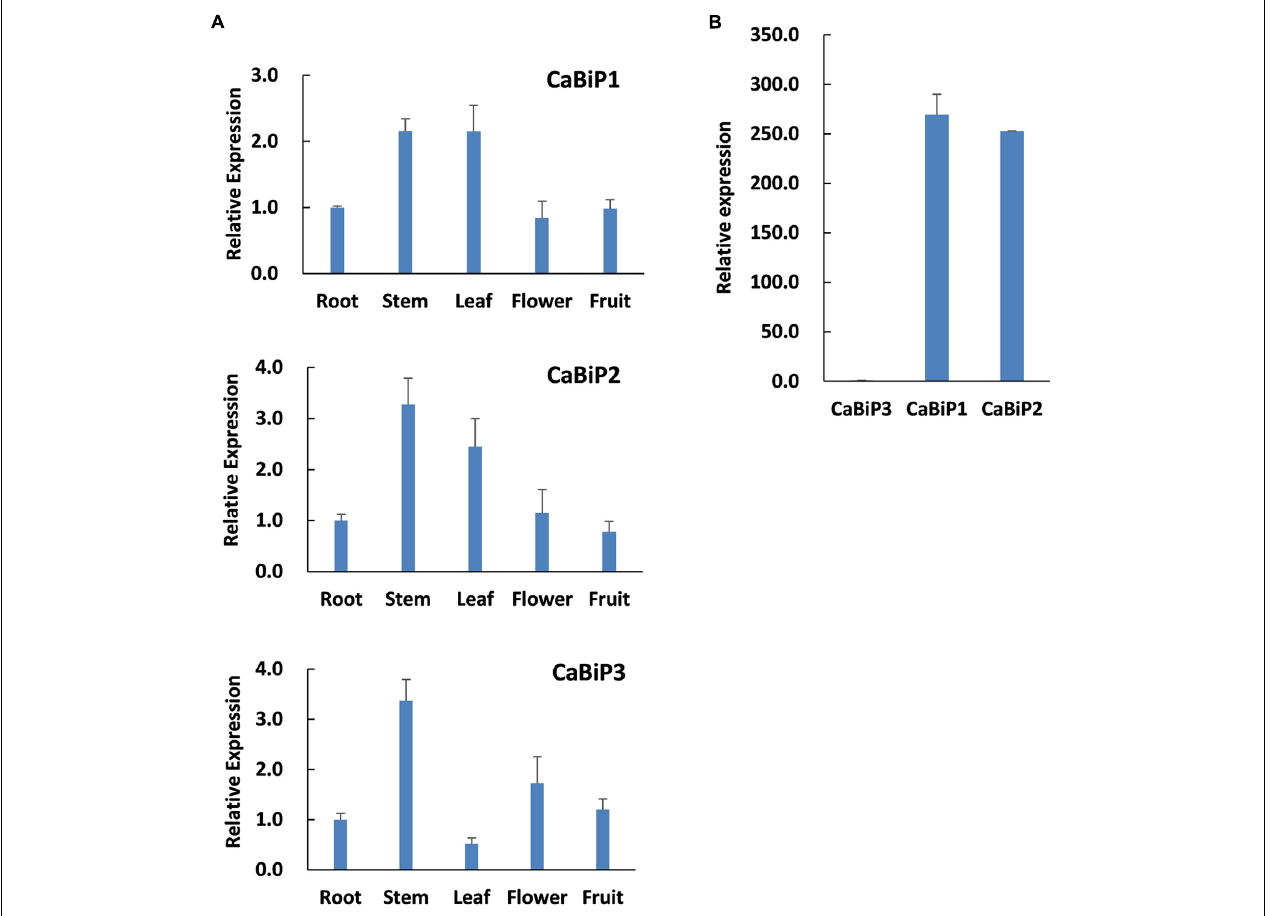
FIGURE 3 | Tissue-specific expression CaBiP genes . (A) Expression of CaBiP1 , CaBiP2 and CaBiP3 in pepper root, stem, leaf, flower and fruit. (B) Relative expression of CaBiP genes in pepper root. The expression level of CaUBI3 was used as the internal control. Bars shows the standard deviation of expression levels from three biological